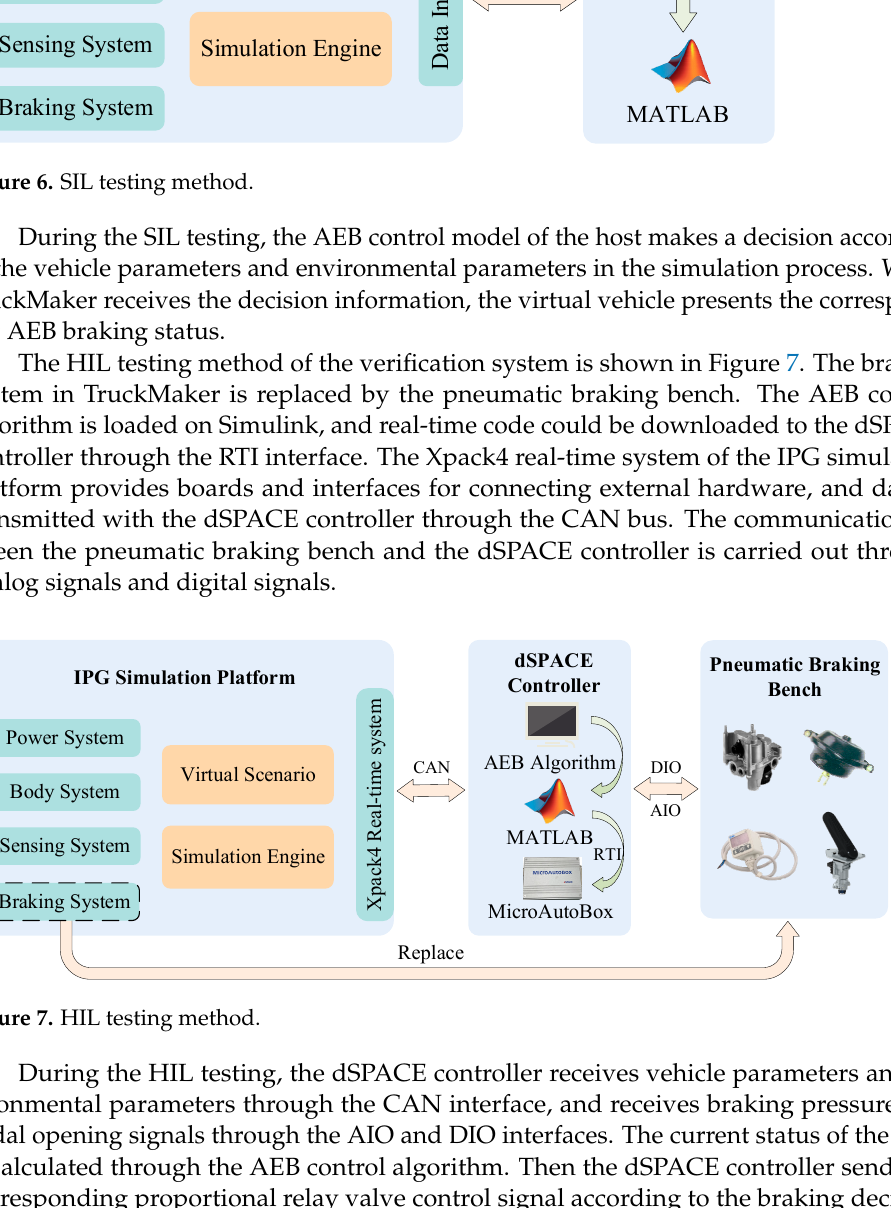
Figure 7. HIL testing method.